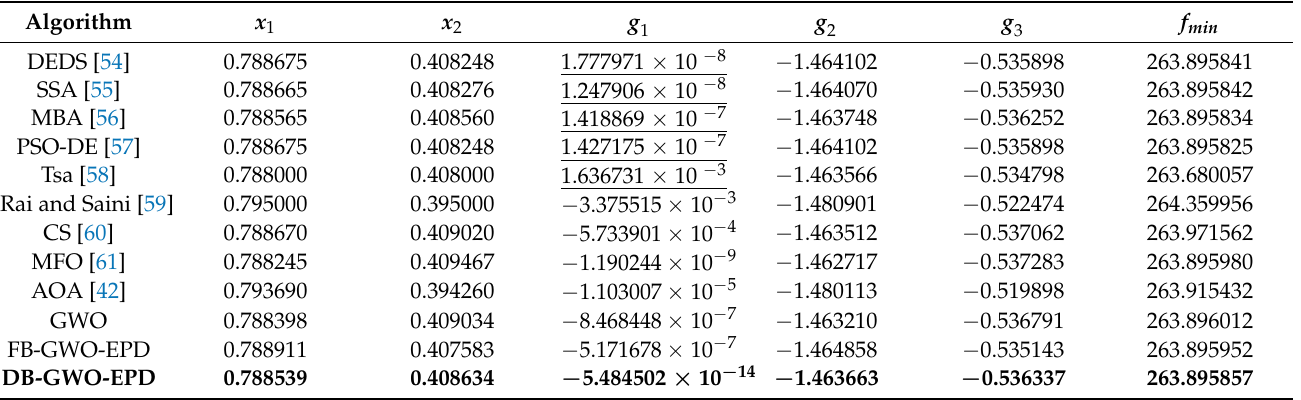
Table 10. Results of solving three-bar truss design problem.